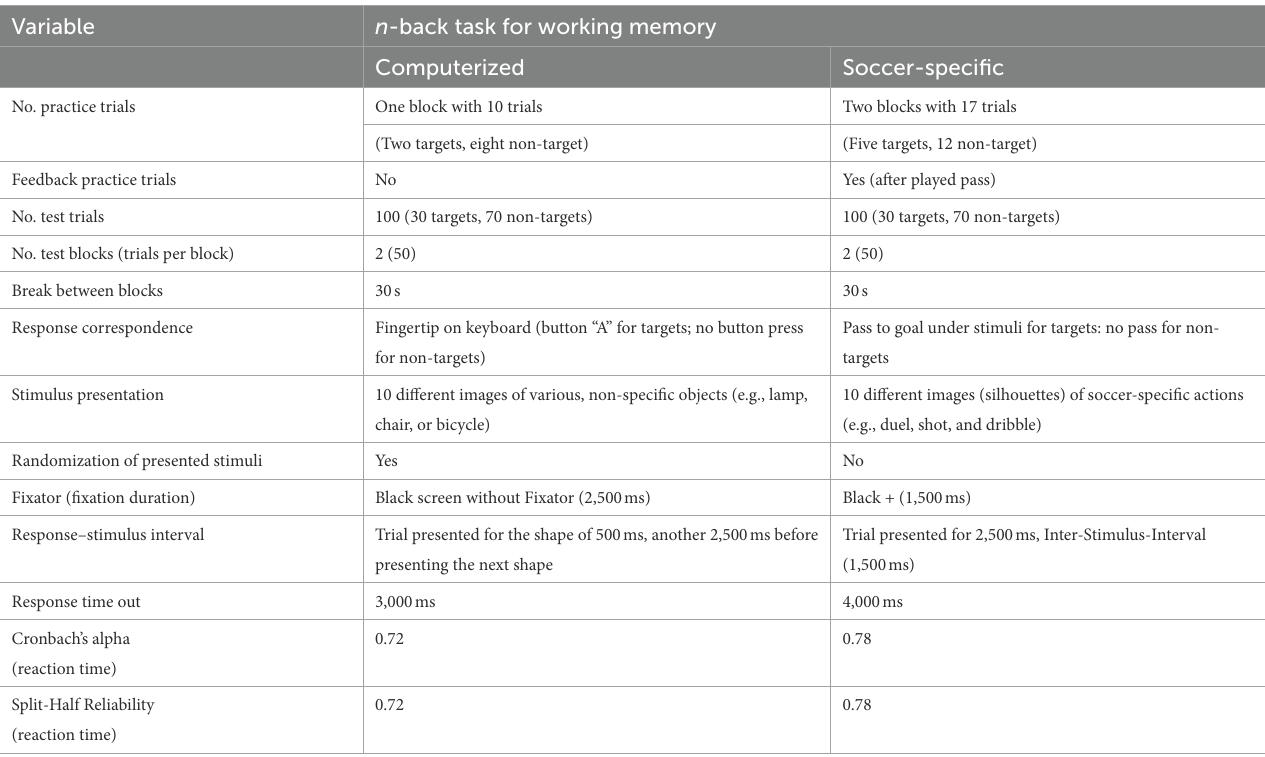
TABLE 1 Comparison of general computer n -back task and soccer-specific n -back